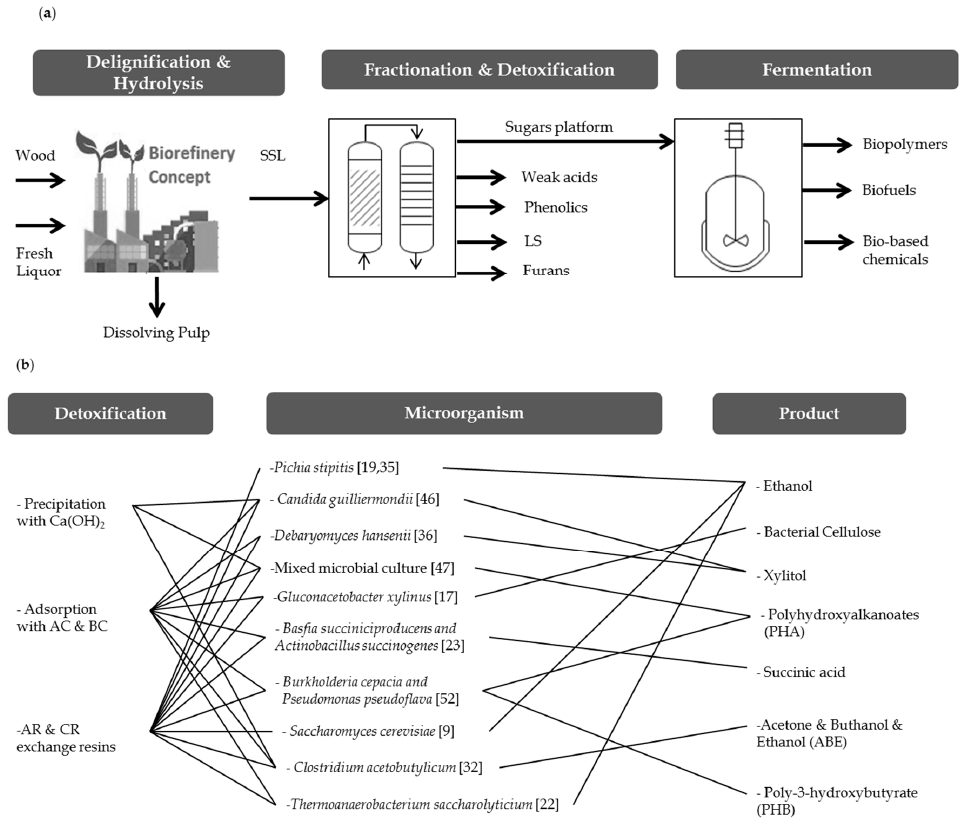
Figure 5. ( a ) Main steps involved in transformation of a sulfite pulp mill into a modern biorefinery; ( b ) Detoxification pathways of lignocellulosic hydrolyzates within common fermenting scenarios.